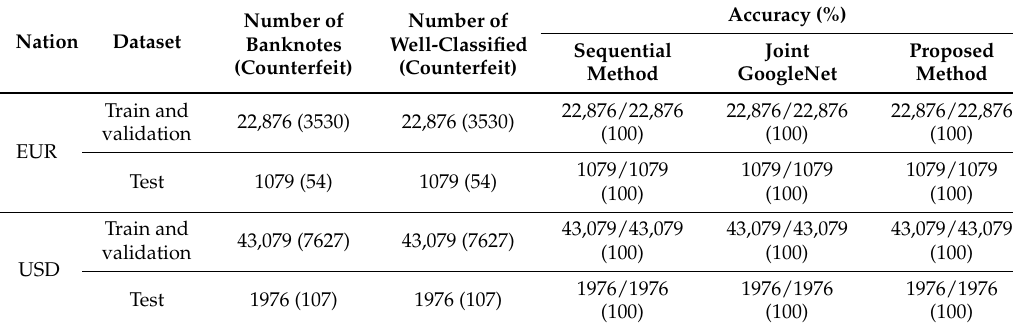
Figure 6. Average batch losses of convergence graphs. Table 3. Accuracy of banknote